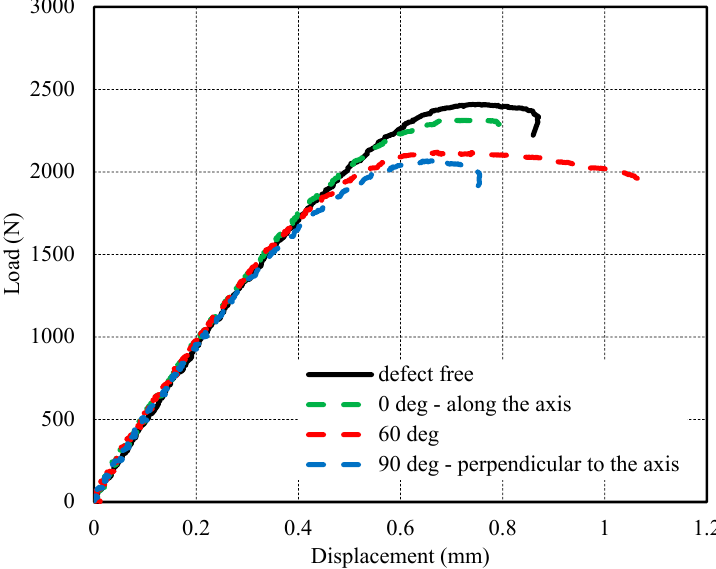
Figure 10. Effect of defect’s orientation on the load-displacement curve of gray set samples. Figure 10. E ff ect of defect’s orientation on the load-displacement curve of gray set